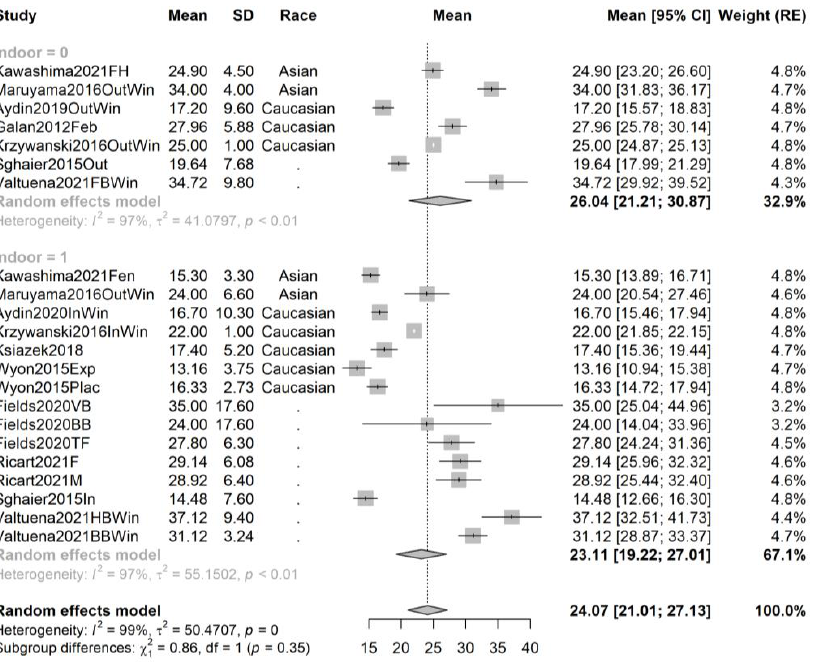
serum vitamin D is higher by 2.93 ng/mL in outdoor athletes (n out = 529 observations from